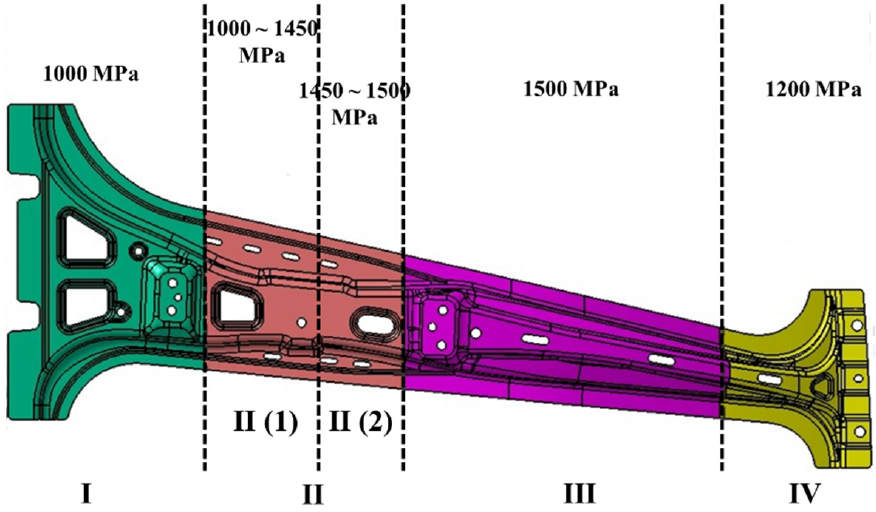
Figure 17. Segments of B-pillar with desired mechanical properties.